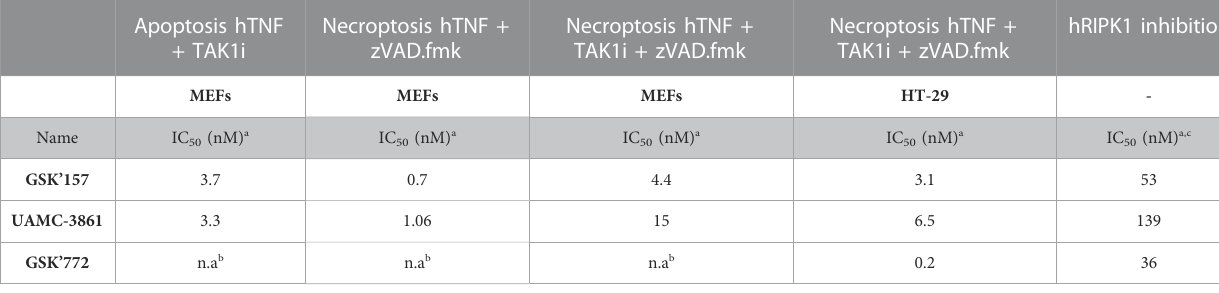
Necroptosis hTNF + TAK1i +